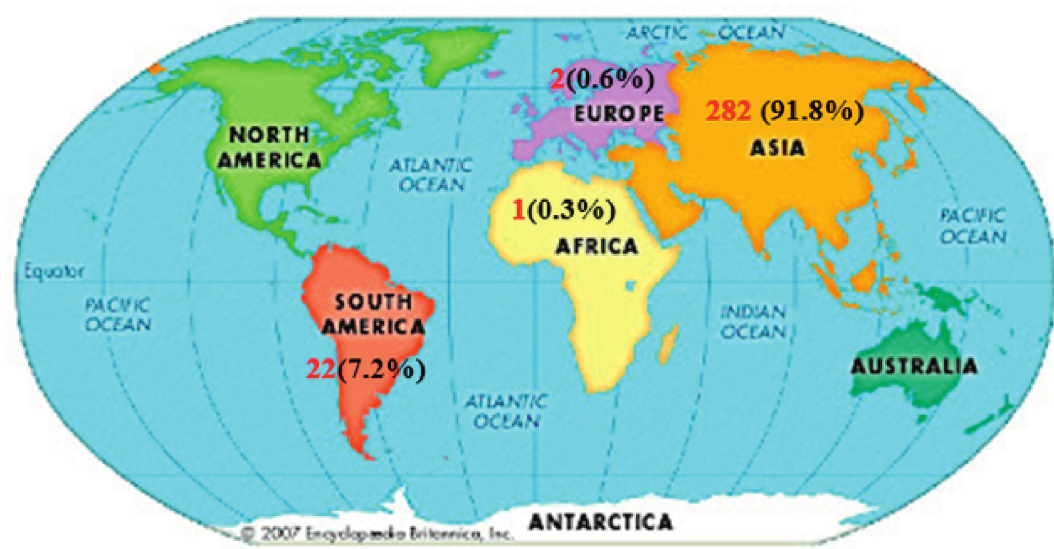
Figure 2: Global distribution of lophomoniasis